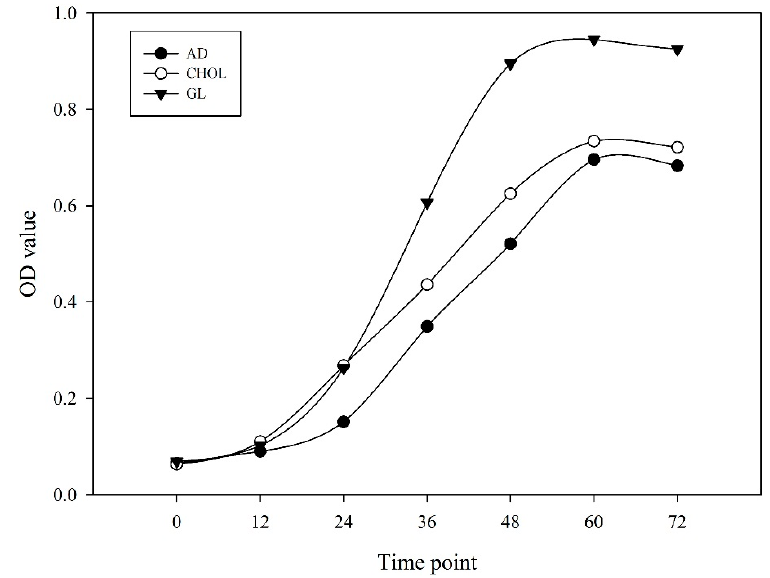
Figure 2. Growth curve of M. smegmatis MC 2 155 grown in different mediums. AD, CHOL and GL correspond to three different conditions: 20 mL minimal medium plus with 1.75 mM androstenedione, 1.29 mM cholesterol and 5.47 mM glycerol respectively.